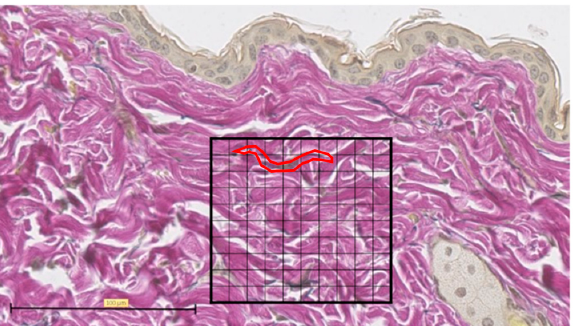
Figure 6. Elastica van Gieson (EVG) staining. Tissue section of normal skin, divided into 100 equal sections of 100 × 100 µ m squares (scale bar 100 µ m). One typical purple-stained elastic fiber is circled sections of 100 × 100 µm squares (scale bar 100 µm). One typical purple-stained elastic fiber is circled in red and counted as 9 blocks. in red and counted as 9 blocks.